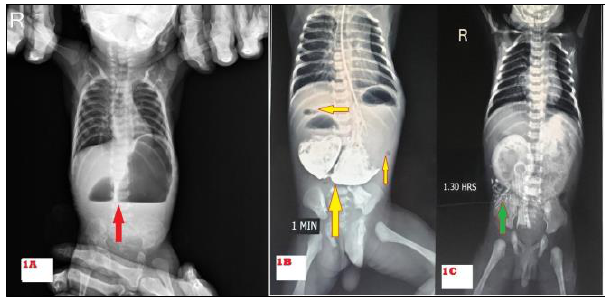
Figure 1: A) Double bubble sign (Red arrow). B & C) Gastrografin upper GI con-